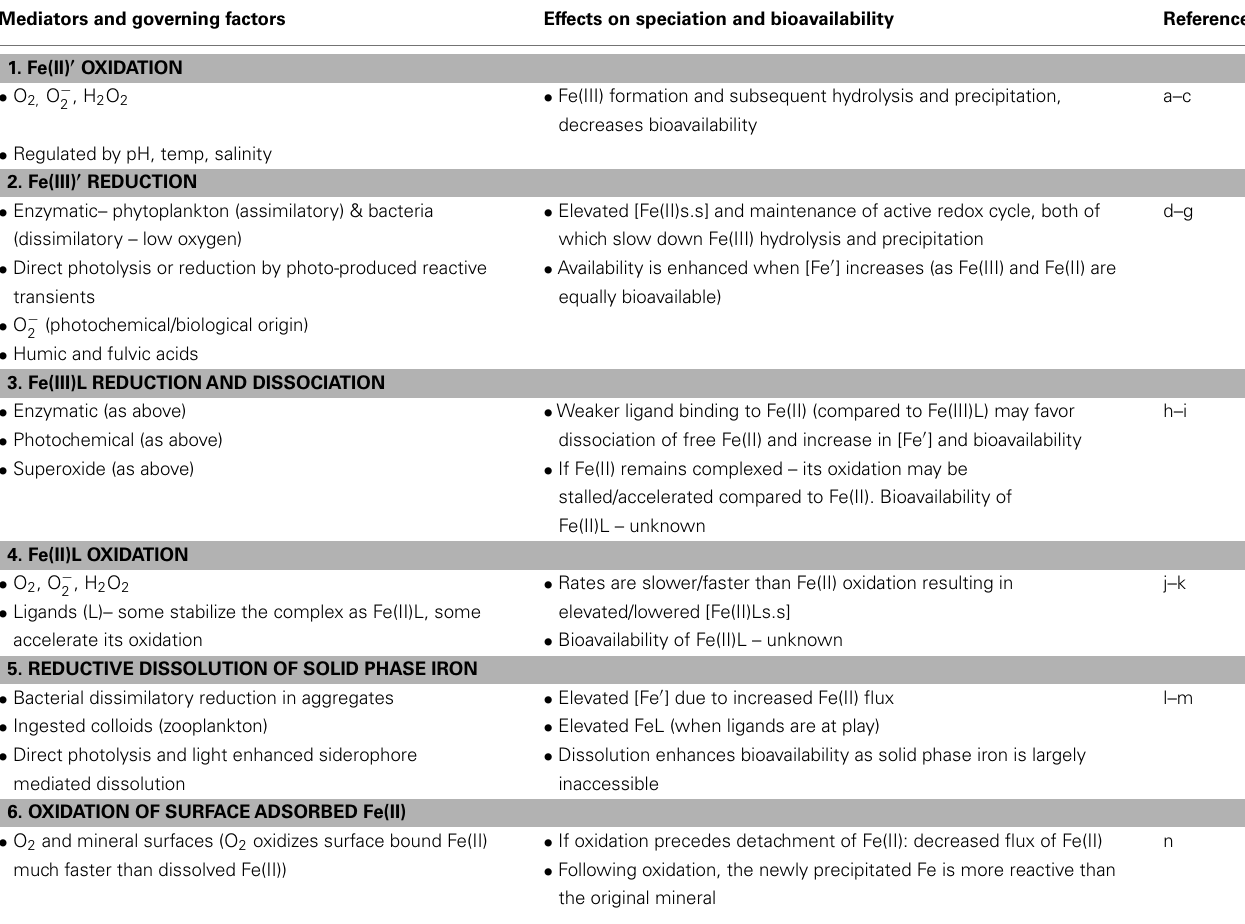
Table 2 | Redox reactions of different Fe species in aquatic environments, their governing factors, and potential influence on Fe speciation and bioavailability (this table accompanies Figure